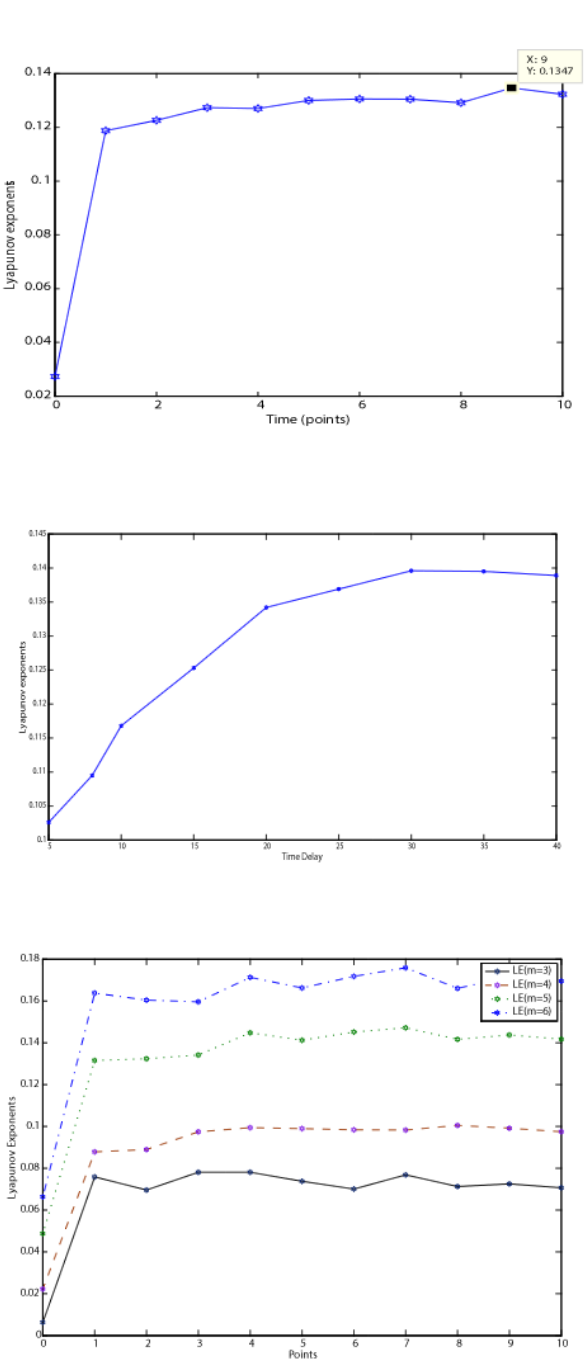
Figure 6. (a) Lyapunov exponent computed and its evolution com- puted as the state space trajectory scanned with τ = 30, m = 5 for detrended time series measured at Yola with the largest Lyapunov exponent equal to 0.1347. (b) Lyapunov exponent computed for a different time delay with a constant embedding dimension. (c) Lya- punov exponents (LE) computed for different embedding dimen- sions ( m = 3, 4, 5 and 6) at a constant time delay.